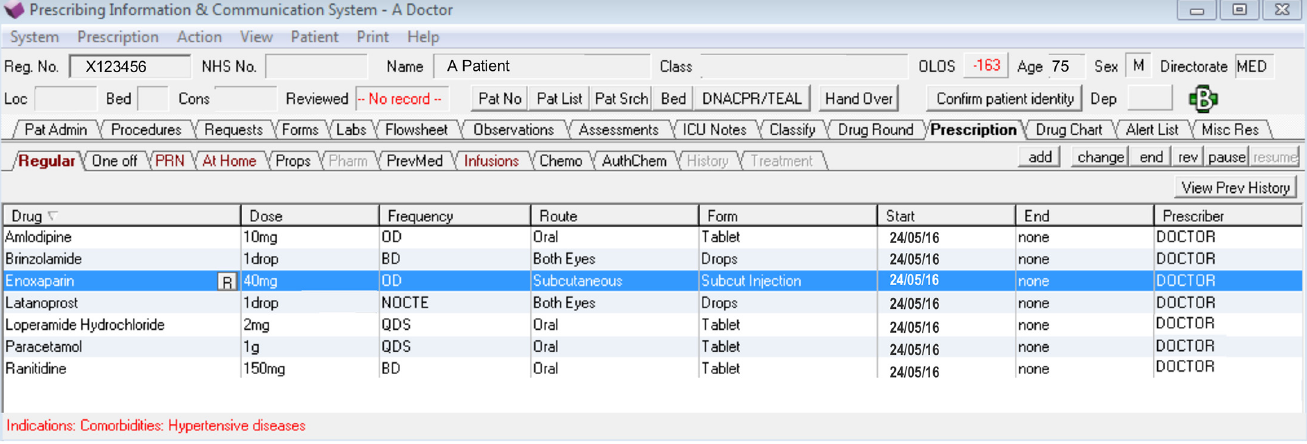
Fig 1. An ‘ R ’ icon indicates the presence of a review message on prescription order ‘ enoxaparin ’ . Prescription profile generated using PICS Training programme.